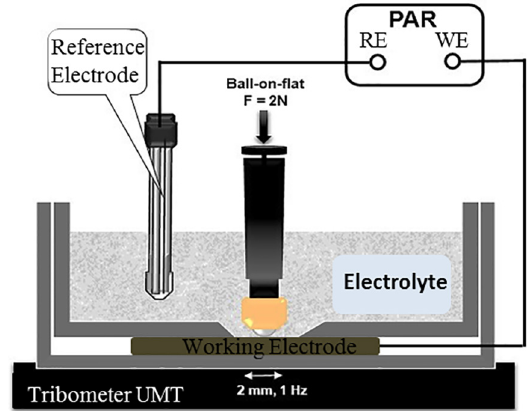
Figure 2: Schematic set-up for tribocorrosion tests. by a ferrite matrix with spheroidized carbides (Figure 3), as expected 9 .